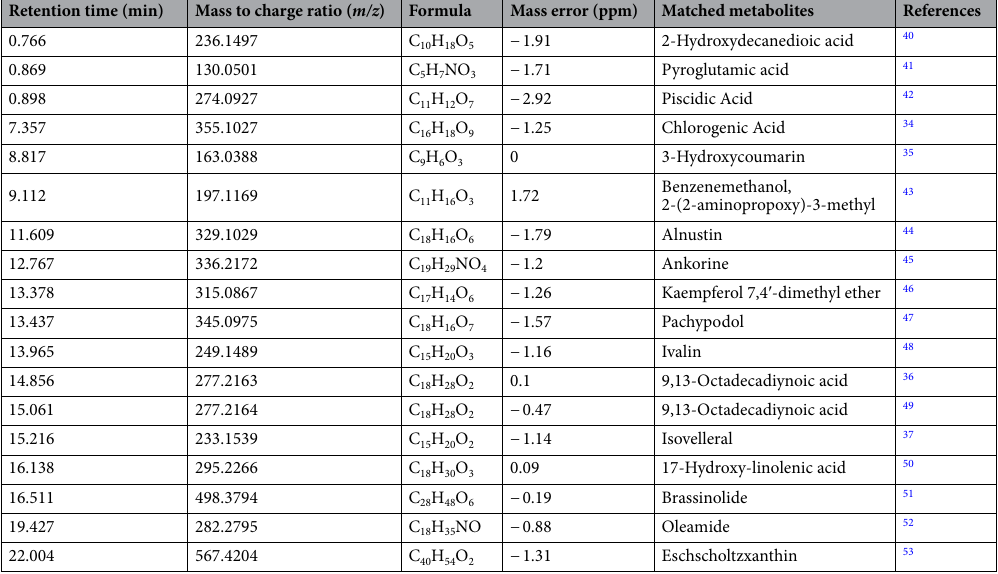
Table 5. Matched metabolites in methanol extract of N. biserrata.